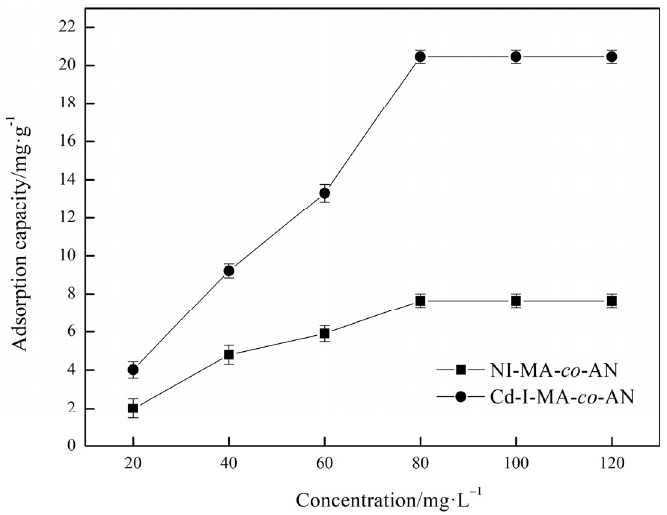
Figure 7. Adsorption isotherm of Cd(II) on Cd-I-MA- co -AN and NI-MA- co -AN.